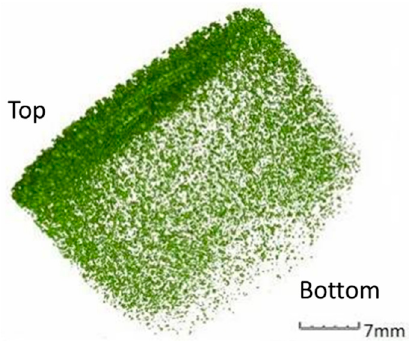
Figure 2. Three-dimensional distribution of voids in the asphalt.